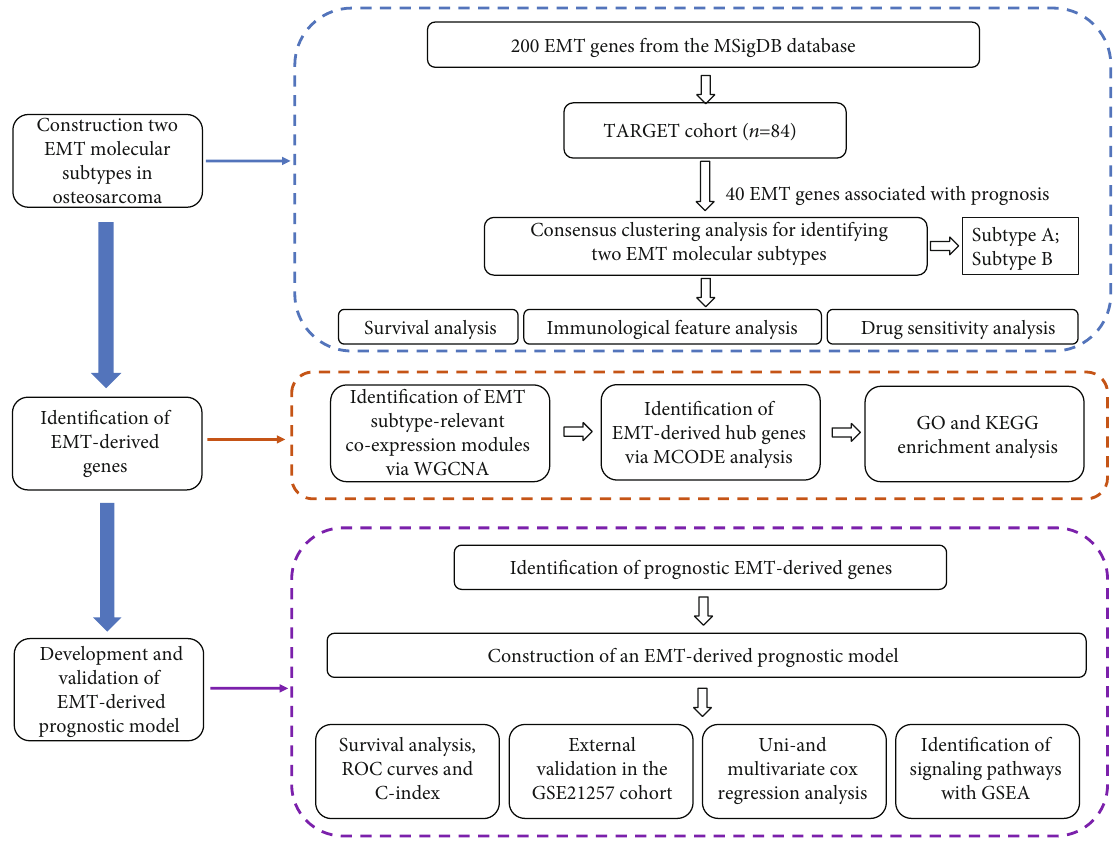
Figure 1: The fl owchart of this